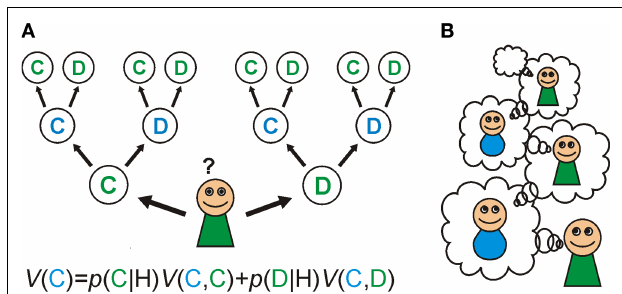
FIGURE 1 | Goal-directed learning of Prisoner’s dilemma. (A) In goal-directed learning, players learn the probability of other player’s action: cooperation (C) or defection (D) based on the history of their actions (H) as p(C|H) and p(D|H). They estimate the value of their own actions: V(C) and V(D) using the prediction from the learned model and the expected reward from the pair of actions. (B) In social games, the model of others leads a recursive process: my model of your action includes a model of your estimate of my actions, and so on. Cooperation in the Prisoner’s dilemma depends on these recursive representations; since when I decide to cooperate this time, I must estimate that you are going to cooperate next time as you believe that I am going to cooperate with